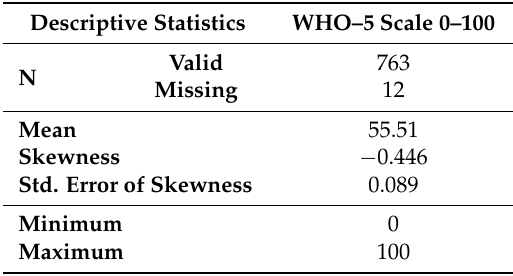
Table 4. Descriptive statistics of wellbeing data in